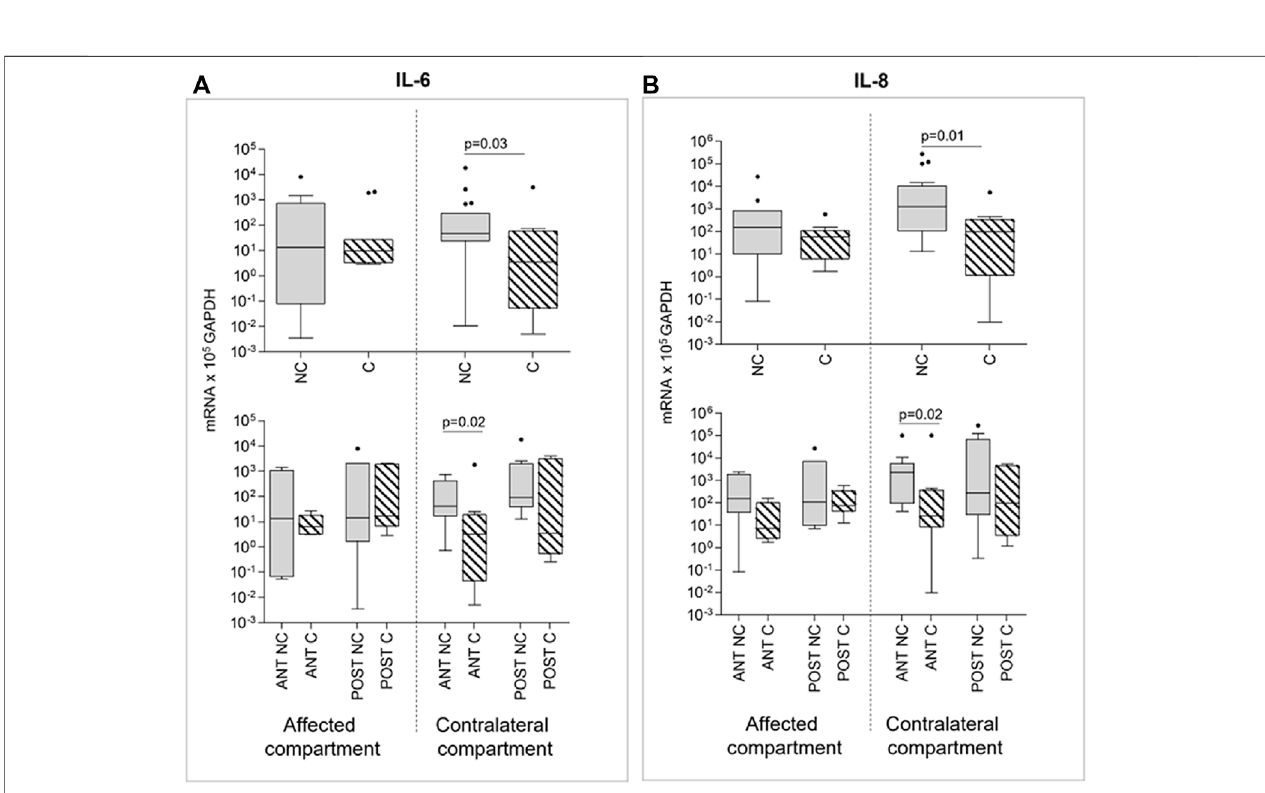
FIGURE5| EffectofcompressiononIL-6 (A) andIL-8 (B) geneexpressioninaffectedandcontralateralcompartments(upperpanels).Inlowerpanels,samplesare dividedaccordingtotheoriginalpositionofthecartilagearea(anterior/posteriorcondyle)(Sidaktestformultiplecomparisons).Dataarerepresentedasmedians(number of mRNA molecules of the gene of interest/10 5 GAPDH copies). Boxes represent 25 th – 75 th percentiles; whiskers represent minimum and maximum values; dots represent outliers. NC= uncompressed; C= compressed; IL-1 β = stimulated with 2 mg/ml IL-1 β .